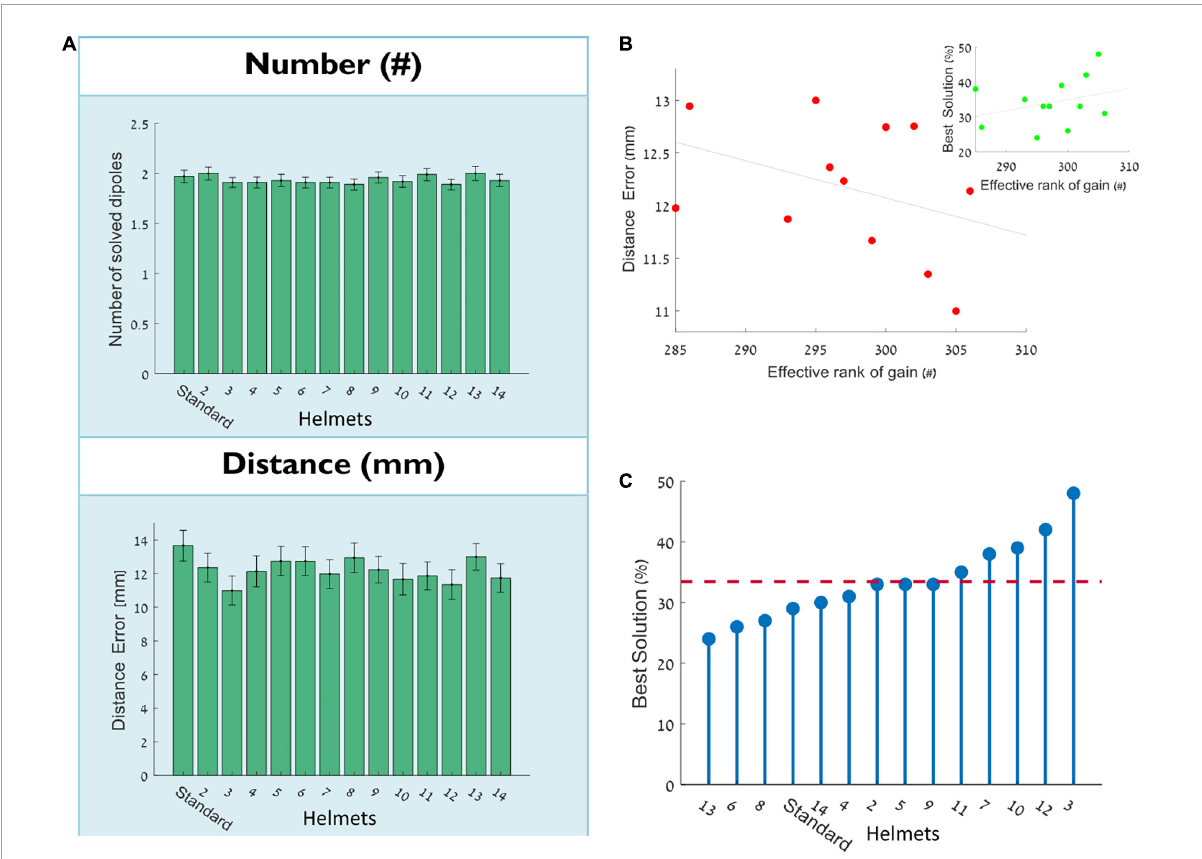
FIGURE3 Assessing the source estimation accuracy by various VMHs. (A) The number of solved dipoles and the distance error: mean ± SEM of the 100 simulations of placed dipole pairs. (B) The relation between the mean distance error to the effective rank of the gain matrix. Each red point represents a VMH ( n = 2, Table 1 ) ( R = –0.38, p > 0.2) [inset: same for the percentage of best solution, as explained in panel (C) , green point represents a VMH ( n = 2, Table 1 ) ( R = 0.31, p > 0.3)]. (C) For each of the tested VMHs and standard helmet, displays the percentage of cases among the 100 placed dipole pairs in which the specific VMH offered the best solution of all the tested VMHs. The x-axis is sorted to emphasize the relative distribution around the